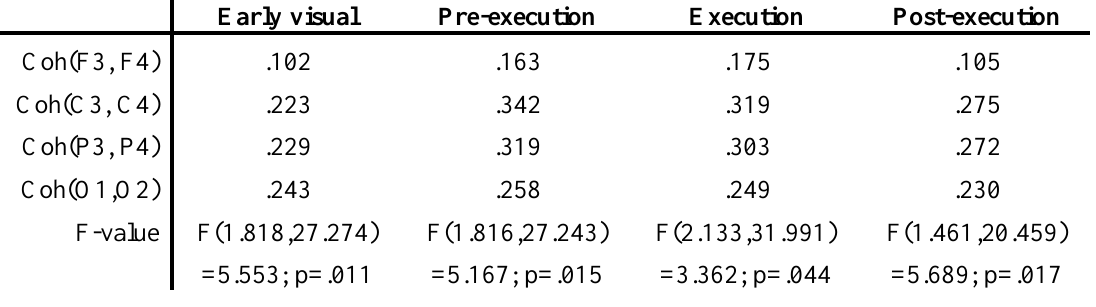
Table 5. The one way repeated measure ANOVAs applied to compare the coherence strength among inter hemispheric pairs during the different